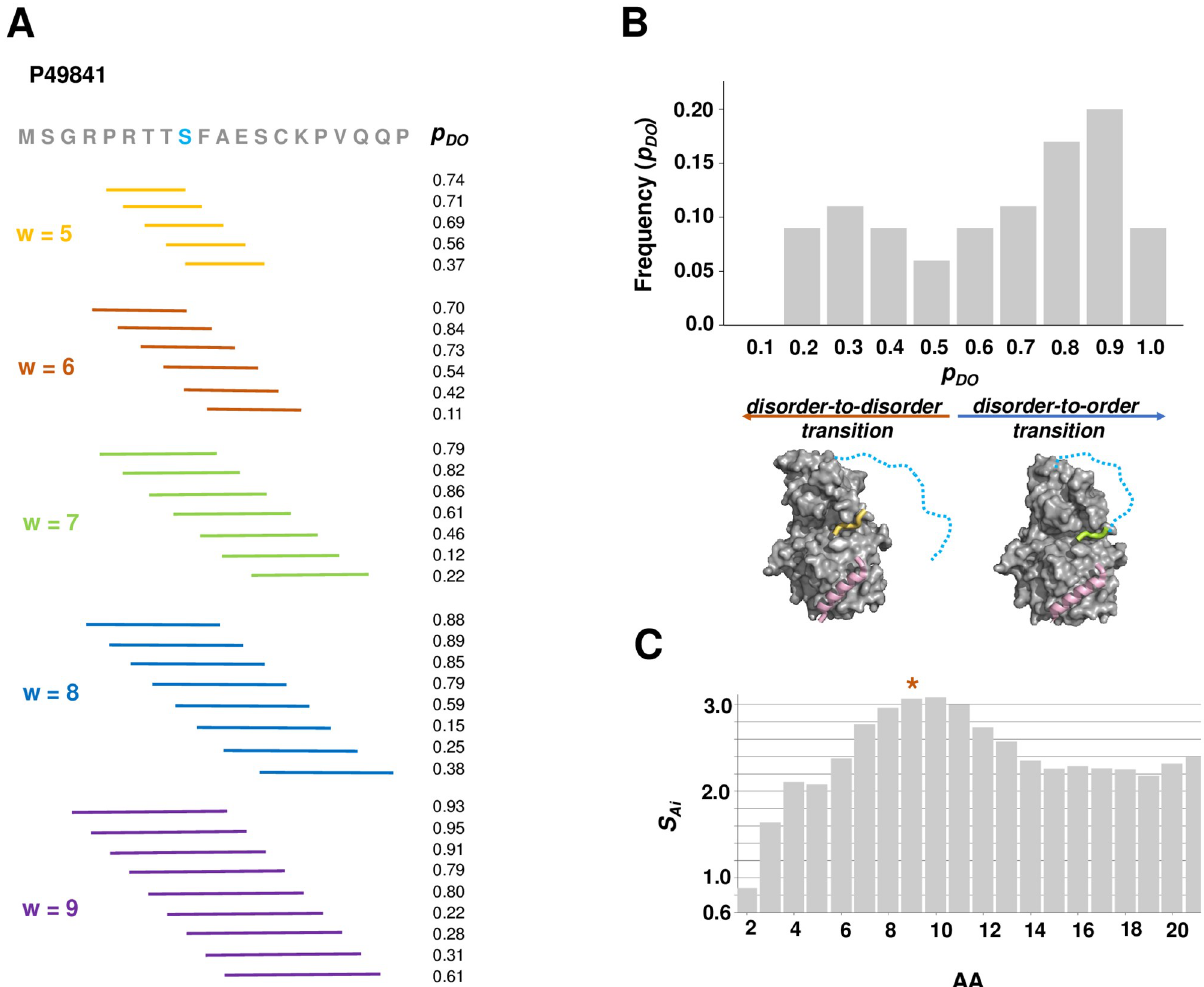
Fig 2. Determination of binding mode diversity. (A) Assignment of possible binding sites. The sequence of the N-terminal 20-residue region of glycogen synthase kinase 3 (GSK3, UniProt P49841) is shown. The possible 5 to 9 residue binding regions of Ser9 are displayed together with their probabilities for disorder-to-order transition ( p ). (B) Frequencies of binding modes. The distribution of the p values for Ser9 are shown. The DO R i DO (R) bimodal distribution of the p DO (R) values indicates that Ser9 can populate both disorder-to-order and disorder-to-disorder binding modes. The interactions with low-density lipoprotein receptor-related protein 6 (LRP6) peptides (wheat) and axin (violet) exemplifies the disorder-to-disorder binding modes (PDB: 4nm5), where the N-terminal region (dashed, cyan) does not adopt a well-defined structure in the complex. Phosphorylation of Ser9 induces folding of the N-terminal peptide (lime), which mediates an auto-inhibitory interaction (PDB: 4nm3)[18]. (C) Shannon entropy for binding modes. The Shannon entropy (Eq 5) is evaluated for the binding mode distribution of each residue. The S values predict increased number of A i possible binding modes for residues 7–11, which is consistent with their conditional